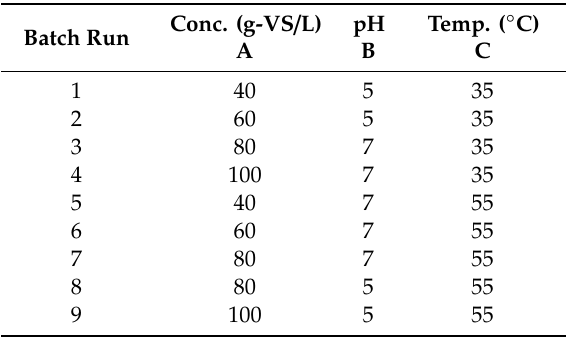
Table 1. Experiment from apply of Taguchi